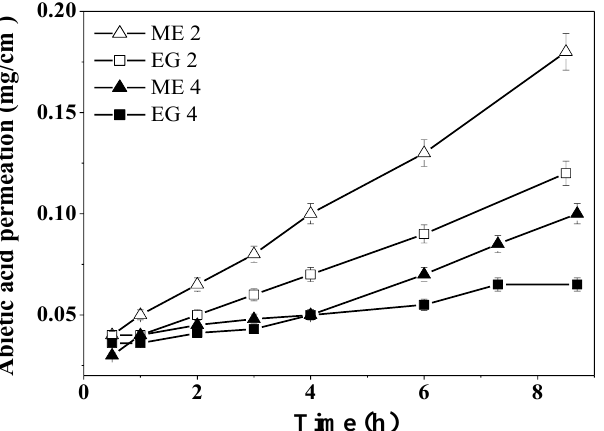
Figure 3. Permeation of abietic acid from the microemulsions and emulgels through Strat-M ® membranes over time, PBS:ethanol (1:1) medium, 34 °C.